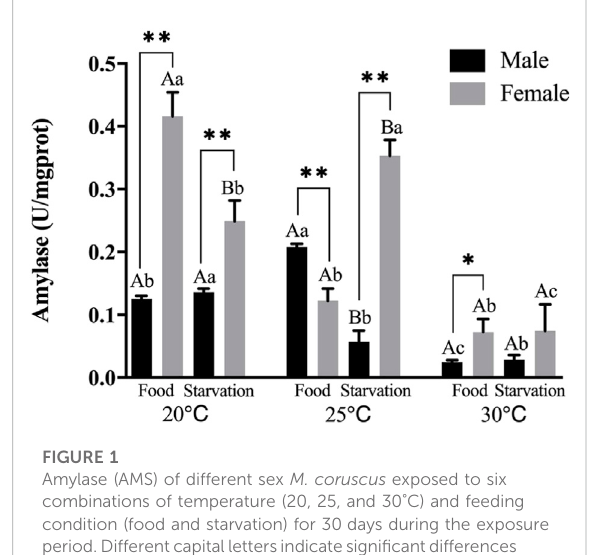
FIGURE 1 Amylase (AMS) of different sex M. coruscus exposed to six combinations of temperature (20, 25, and 30 ° C) and feeding condition (food and starvation) for 30 days during the exposure period.Differentcapitallettersindicatesigni fi cantdifferences between the feeding condition and each temperature levels (20, 25, and 30 ° C) ( p < 0.05). Different small letters indicate signi fi cant differences between temperature (20, 25, and 30 ° C) and the same feeding condition ( p < 0.05). Asterisk indicates signi fi cant differences between sex and each feeding condition, in which * representssigni fi cantdifference( p < 0.05)and**representshighly signi fi cant difference ( p <